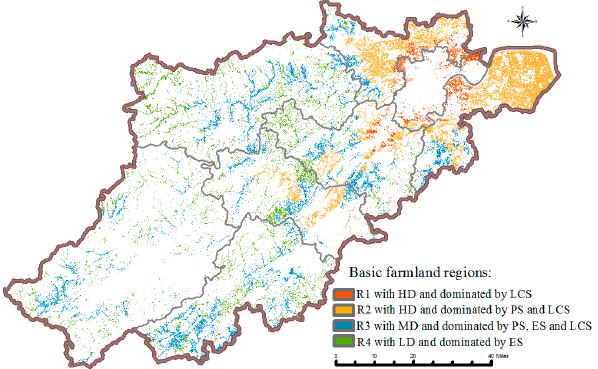
Figure 7. Basic farmland regions divided according to the supply-and-demand matching condi- tions for farmland functions calculated through the spatial clustering analysis (HD, MD and LD are the abbreviations of high demand, medium demand and low demand, respectively; PS, ES and LCS are the abbreviations of production function, ecological function and landscape-cultural functions, respectively).